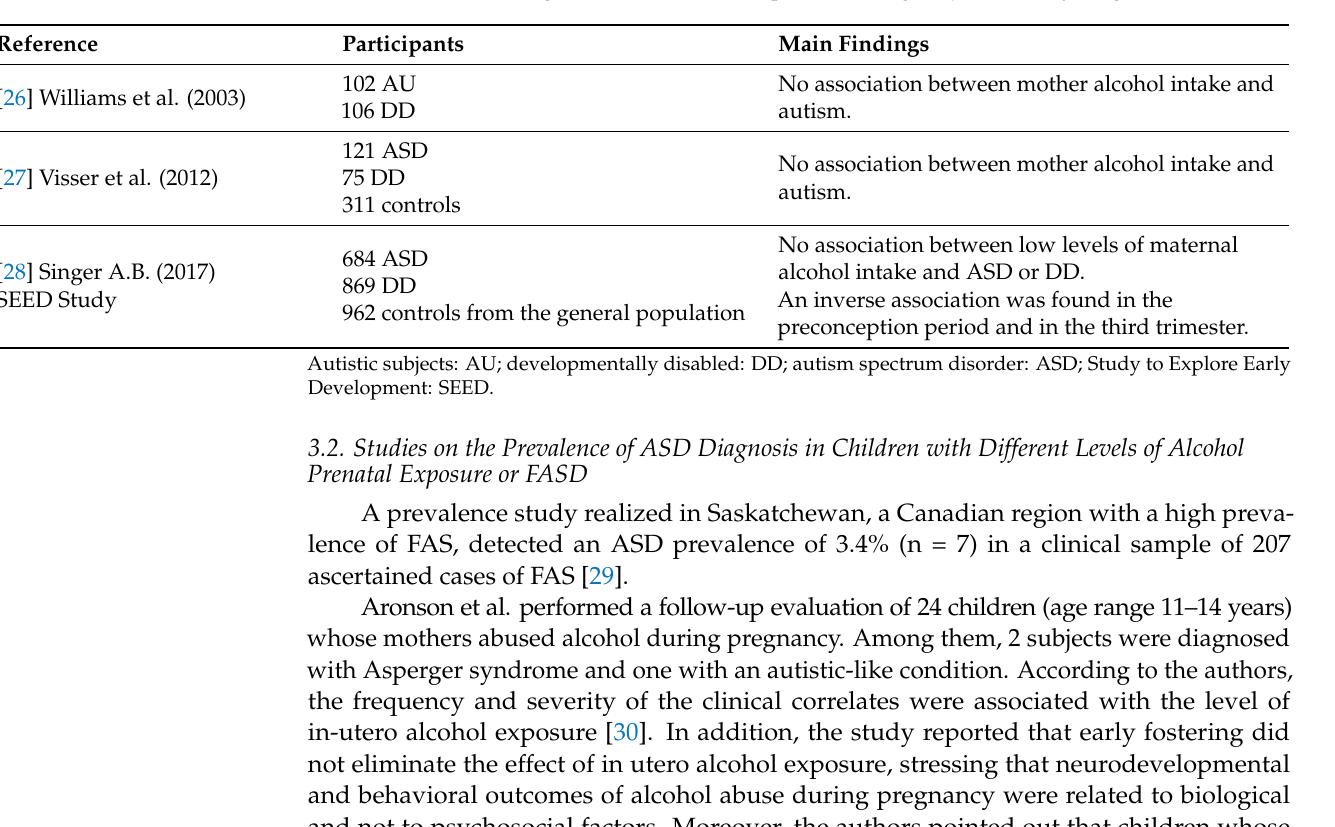
Table 1. Studies focusing on in utero alcohol exposure among subjects already diagnosed with